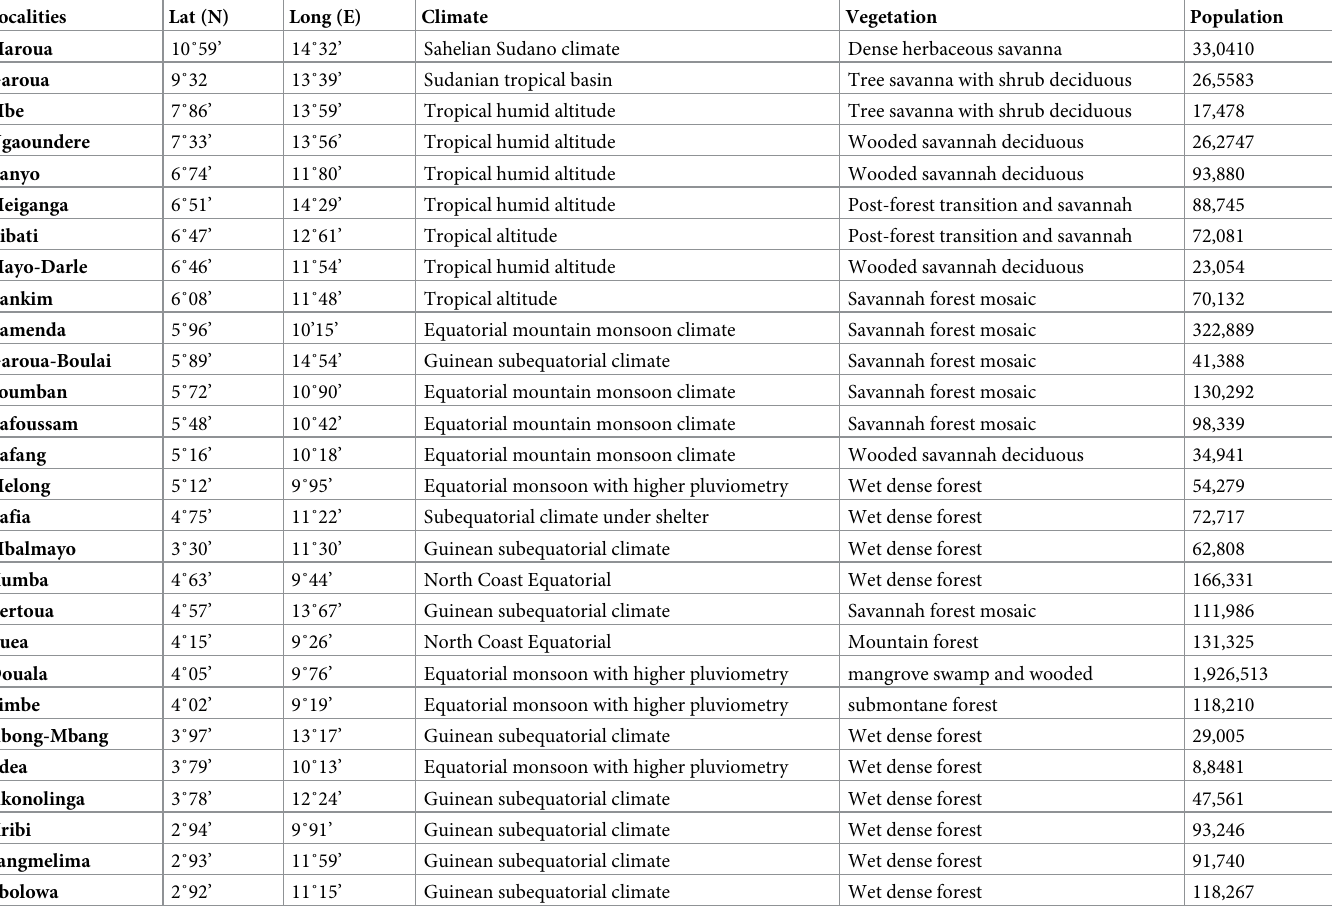
Table 1. Environmental characteristics of different prospected sites in